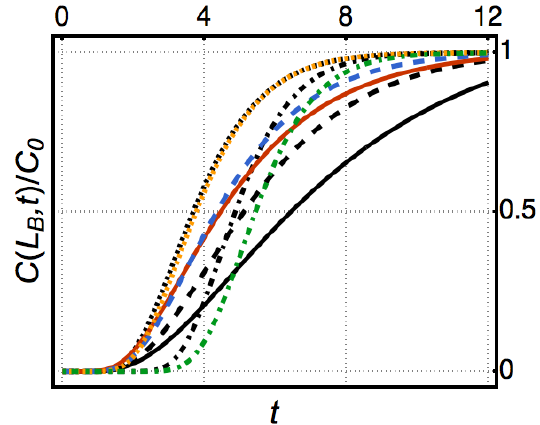
Figure 9. Breakthrough curves obtained from solving Equation (16) for a simple linear adsorption process given by ˙ ρ = − r a C b ( z ) with r a the adsorption rate and D 0 the diffusion coefficient. The pores considered are the winding (black lines) and tortuous (colour lines) pores with length L = 5. The boundary conditions consist of fluid entering at the left ( C b ( z = 0 ) = 1), and exiting at the right ( C b ( z = L ) = 0). The values of the constants (in arbitrary units) were r a = 0 and D 0 = 1 for the solid lines, r a = 0.1 and D 0 = 0.75 for the dashed lines, r a = 0.4 and D 0 = 0.5 for the dotted lines, and r a = 1.0 and D 0 = 0.1 for the dash-dotted lines. In order to obtain the breakthrough curve, the temporal increasing of the concentration is measured at z = 4.5. Our theory predicts that a small difference on the slope of these curves can be the result of purely geometrical changes, and the constriction and sinuosity of the pores can be reflected in this type of curves. See Appendix A